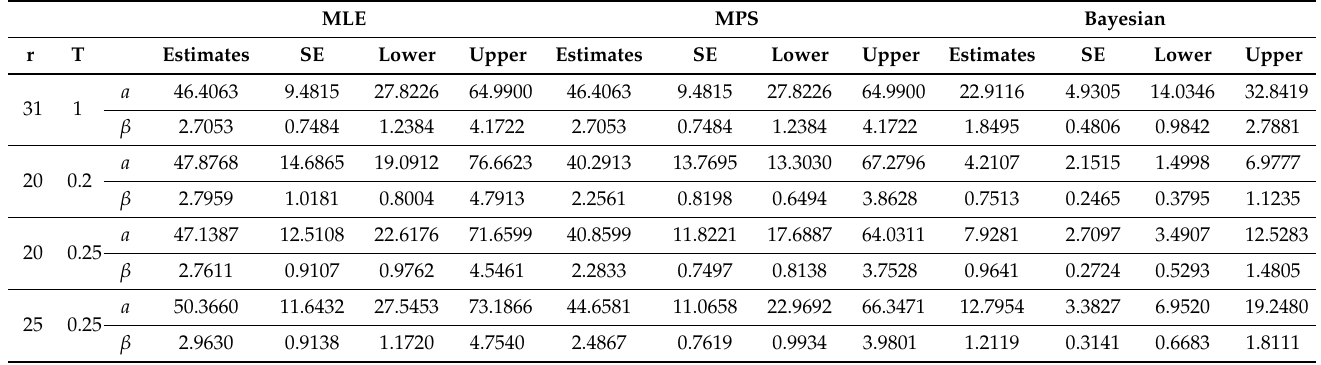
Table 12. MLE, MPS, and Bayesian estimation for parameters of TCP-ITL based on hybrid censored samples: Data